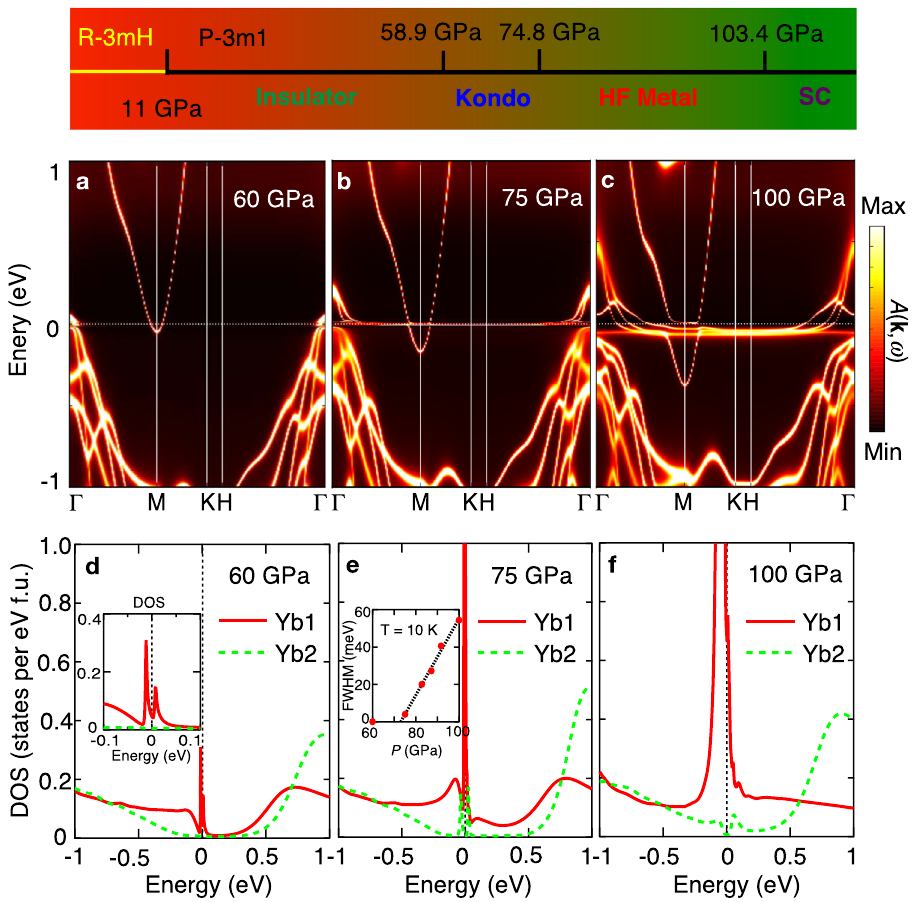
Fig. 2 Electronic phases of NaYbSe 2 under pressure. The upper fi gure illustrates the predicted phases: the charge-transfer or band insulator, the Kondo semimetal (Kondo), the heavy-fermion metal (HF), and the superconductivity (SC). The pressures denote a rough boundary of these phases from experiment 19 . a – c The DFT + DMFT spectral functions at 10 K for 60, 75, and 100 GPa, respectively. d – f The corresponding density of states on two inequivalent Yb ions, showing the development of a sharp quasiparticle peak of Yb1-4 f electrons. The inset in d is an enlarged plot over a smaller energy window to show the pseudogap structure near the Fermi energy at 60 GPa. The inset in e plots the full width at half maximum (FWHM) of the Yb1 quasiparticle peak as a function of pressure, where the solid line is a linear extrapolation giving a transition at about 73